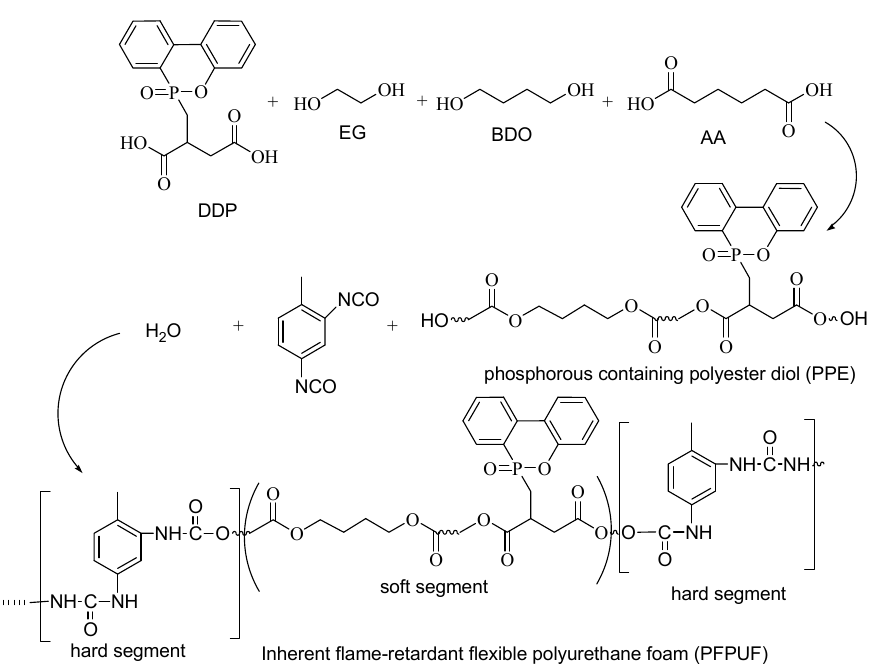
(Mw/Mn) were 2446 g/mol and 1.65 based on polystyrene standard, respectively, indicating